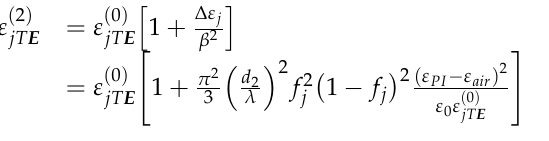
where d 2 was the width of the cube, d(z) was the width of each layer, and f j was the filling rate of the j th layer of the